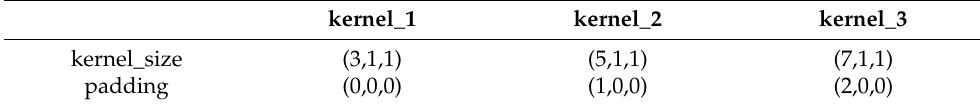
Figure 3. The structure of Multi-scale Temporal Aggregation (MTA). The MTA module employed several parallel convolutions and slides on sequence dimensions to obtain the features at different scales. Table 1. The structure of MTA.